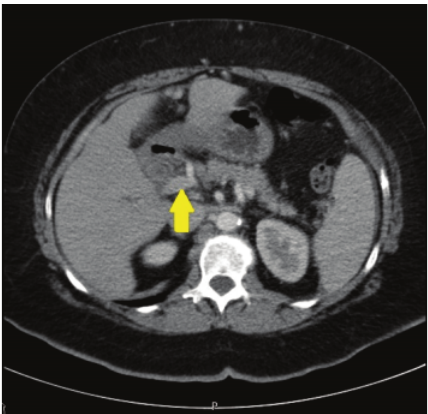
Figure 1: CT abdomen with and without contrast.